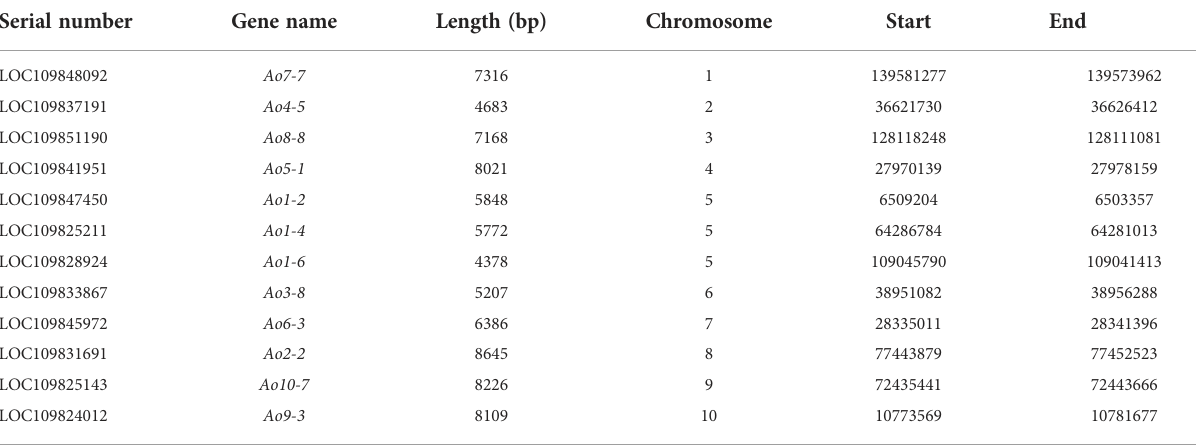
TABLE 1 The information of single copy genes used for chromosome identi fi cation in garden asparagus.